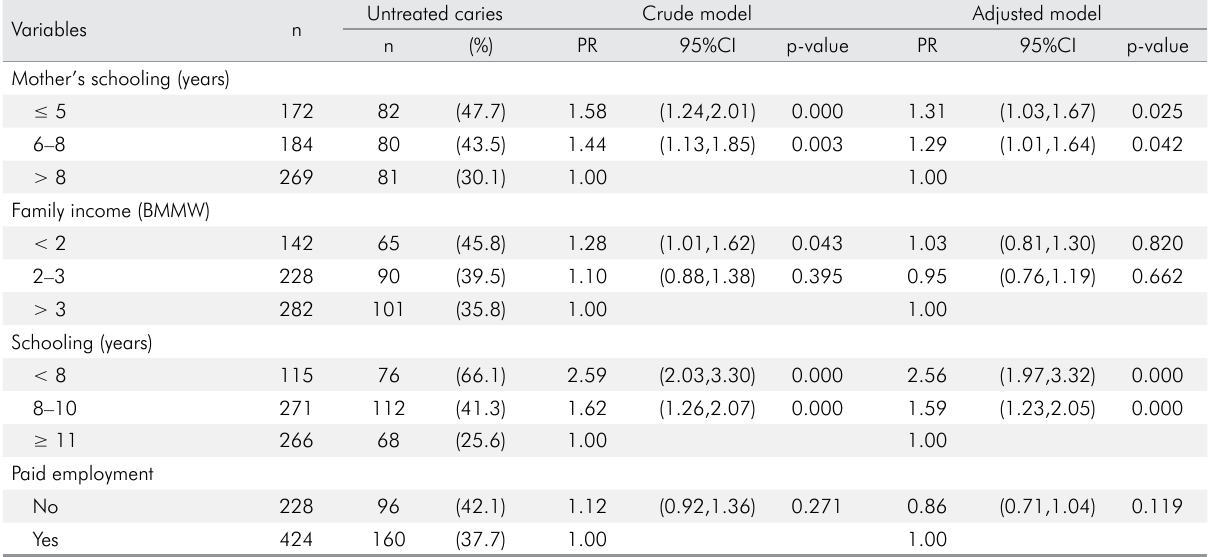
Table 1. Prevalence, crude and adjusted prevalence ratios (PR) and 95% confidence intervals for untreated dental caries in male adolescents from southern